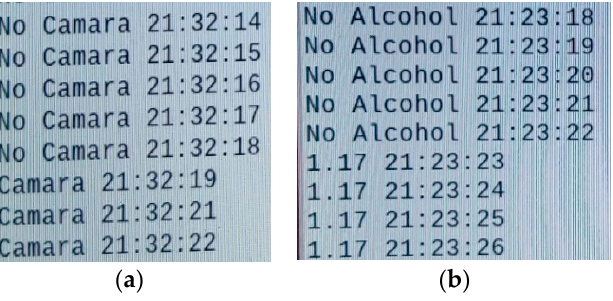
Figure 8. Records made with ( a ) the camera and ( b ) the MQL module.